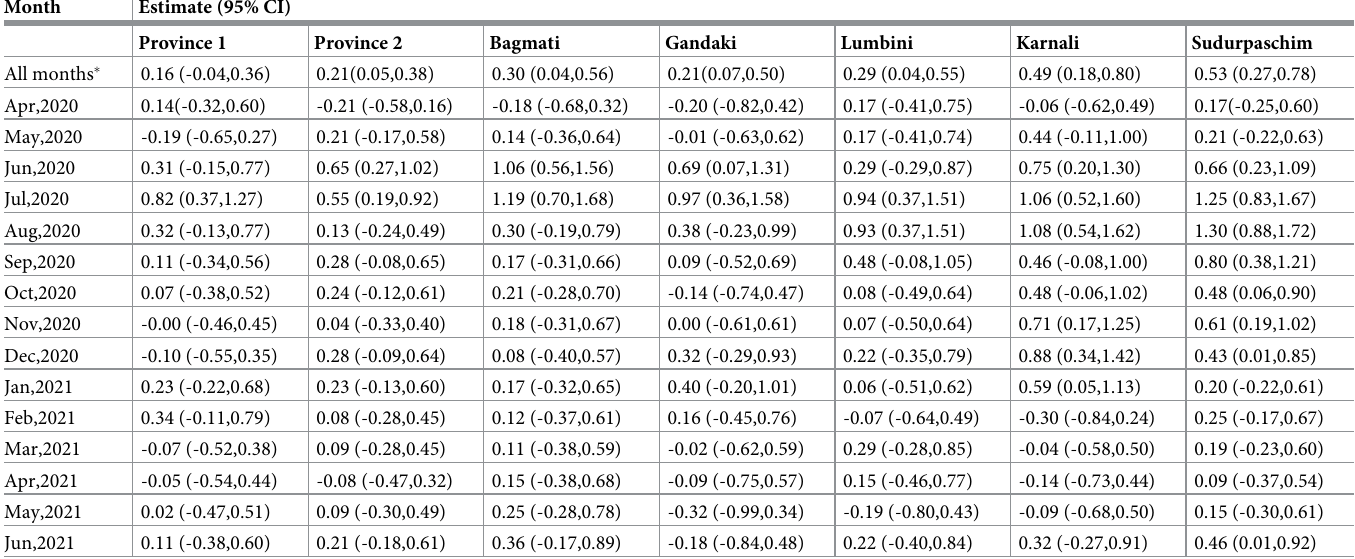
Table 4. Adjusted estimated difference in province-level monthly suicide rate per 100,000 population during COVID-19 pandemic compared to same months in the pre-pandemic